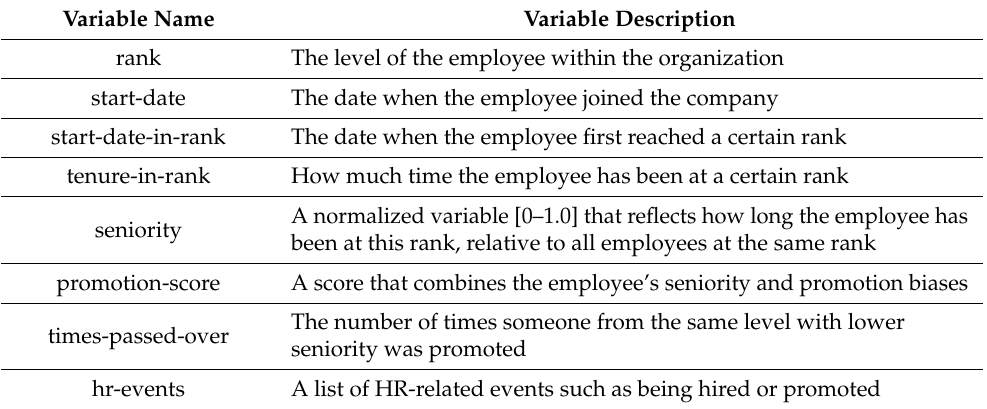
Table 1. List of employee agent variables tracked in the simulation.